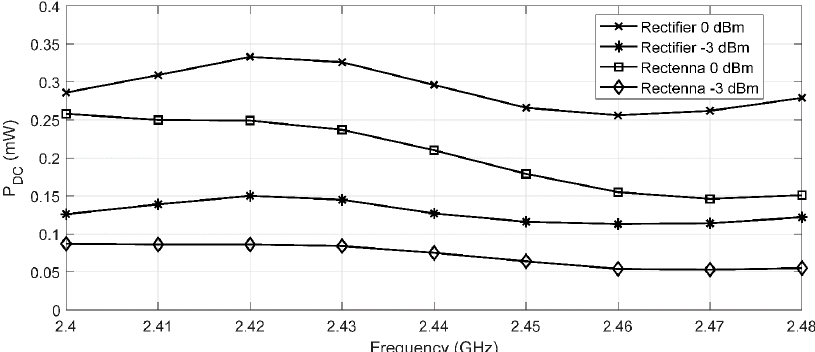
Figure 14. Rectifier vs. Rectenna output DC power P DC comparison.